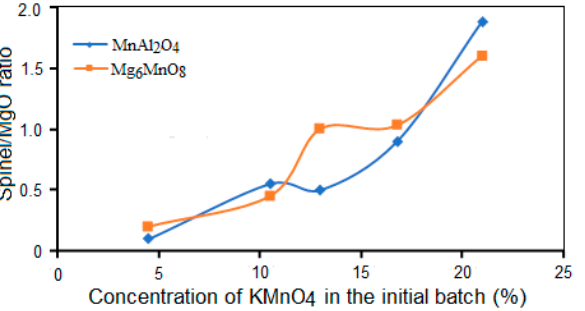
Figure 4. Influence of KMnO 4 concentration in the initial batch on Mn spinels formation.